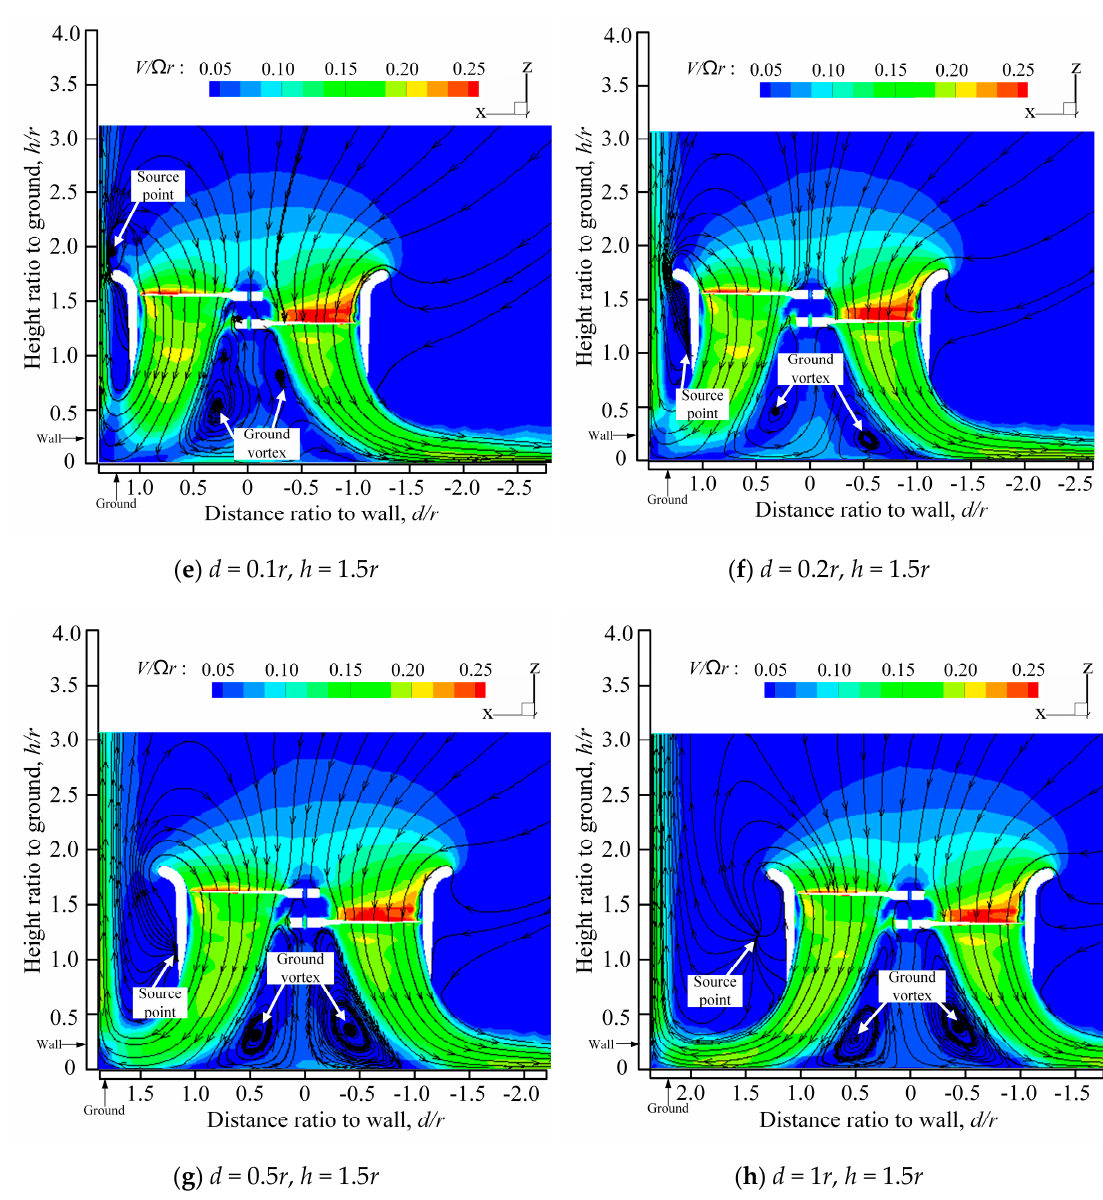
Figure 4. The velocity cloud graphs of a ducted fan at different positions with the corner effect.